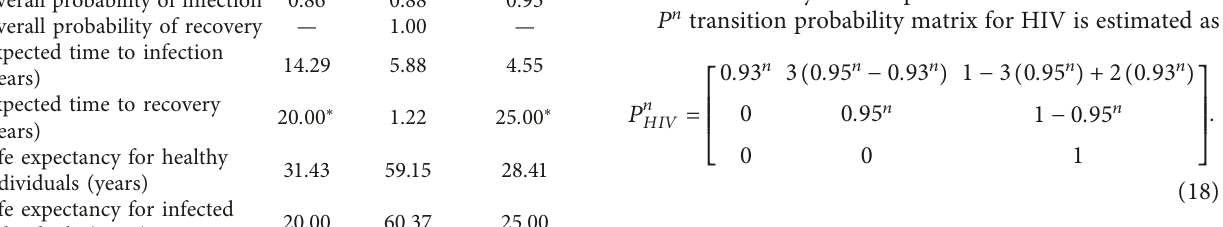
Table 9: Estimates of other disease metrics for each disease. Metrics Overall probability of